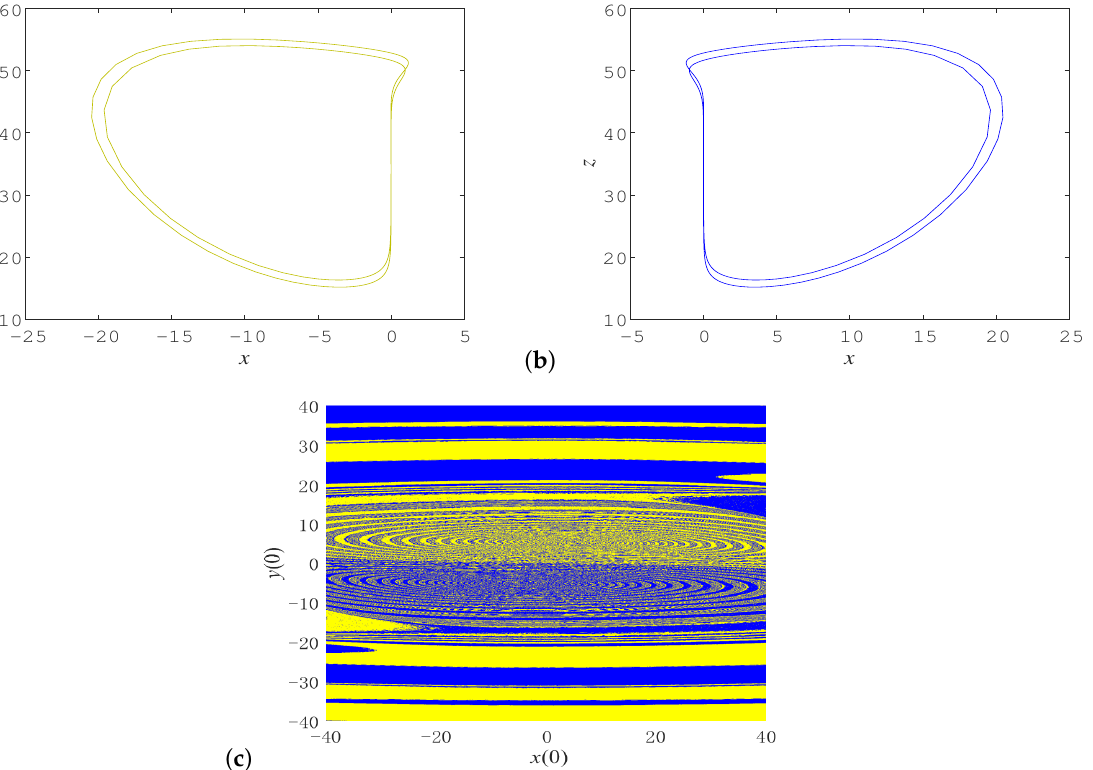
Figure 7. Two coexisting periodic attractors of system (2); ( a , b , c , d ) = ( 35,0.5,35,10 ) : ( a ) periodic attractor with initial values ( − 1, − 1,1 ) ; ( b ) another periodic attractor with initial values ( 1,1,1 ) ; ( c ) basins of